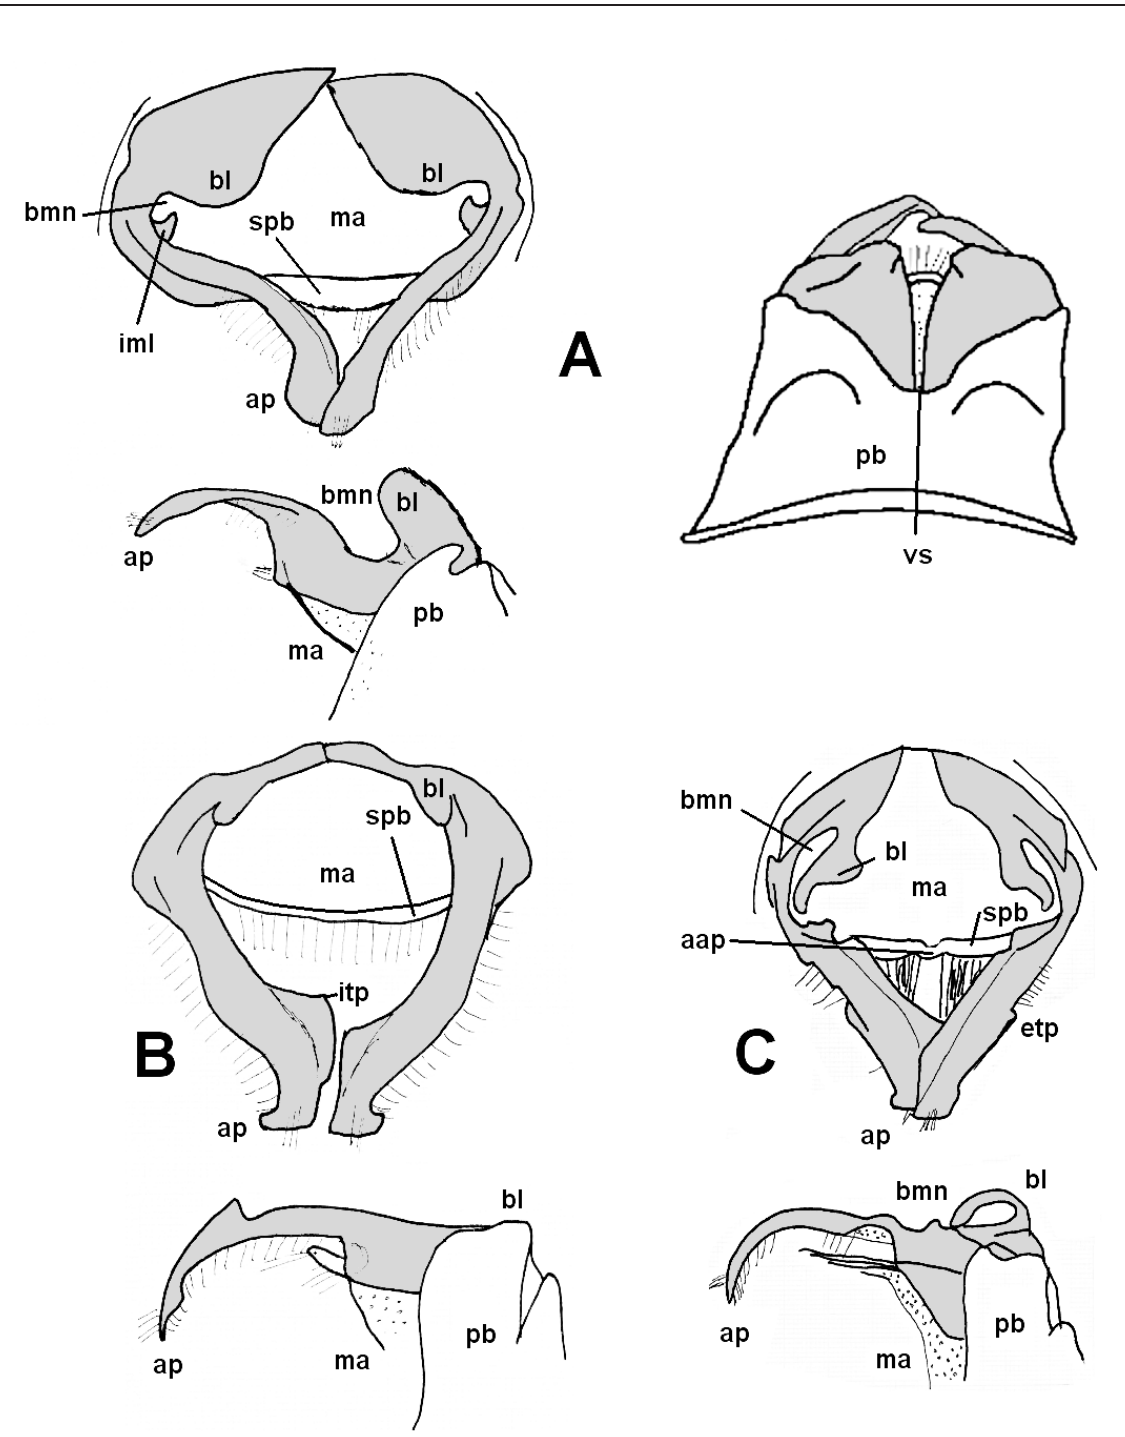
Fig. 3. Different shapes of aedeagus. A . Hybovalgus fraternus Moser, 1904. B . H. thibetanus (Nonfried, 1891). C . H. tonkinensis Moser, 1904. Proposed nomenclature of Hybovalgus aedeagus: aap = anterior apex of phallobase; ap = apex of parameres; bl = basal lobe; bmn = baso-medial notch; etp = sub-apical external tooth of parameres; iml = internal medial lobe; itp = sub-apical internal tooth of parameres; ma = membrane of aedeagus; pb = phallobase; spb = sclerotized upper anterior part of phallobase; vs = V-shaped ventro-apically membranous region of aedeagus. Drawings: grey parts: parameres; white parts: